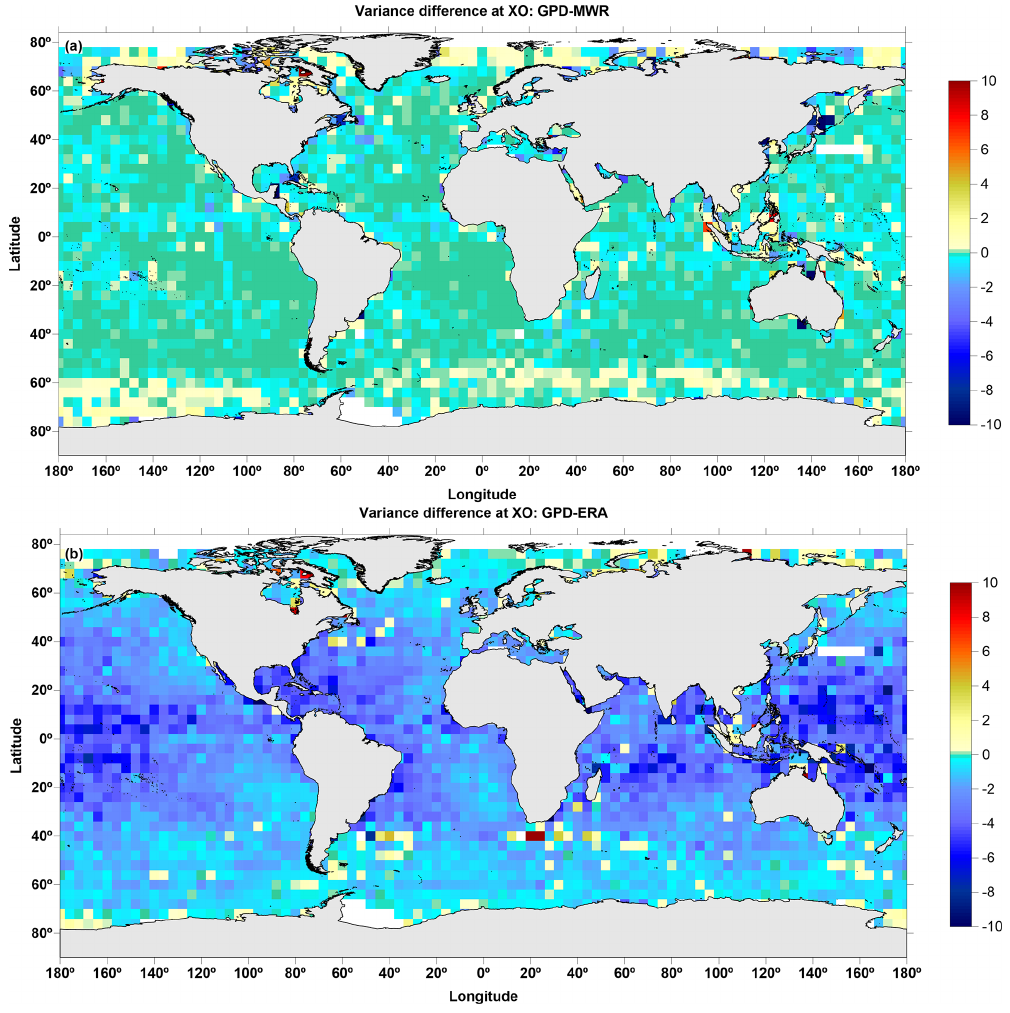
Figure 12. Spatial distribution of the weighted SLA variance differences (in cm 2 ) at crossovers (XO) between (a) GPD + and the MWR- derived WTCs and (b) GPD + and the ERA-Interim WTCs for the whole Envisat period (cycles 6 to 113). The green colour represents SLA variance differences around zero. Pixels with no data are shown in